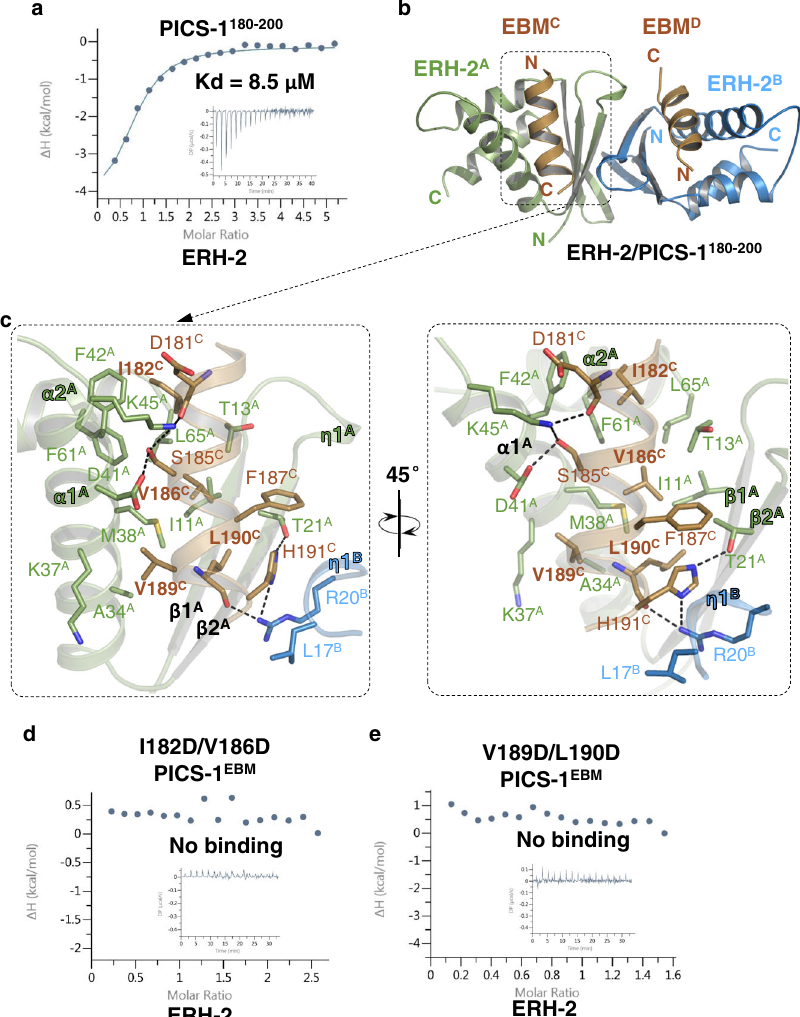
Fig. 3 The structure of ERH-2 dimer bound with EBM. a ITC binding curves for EBM with ERH-2. b Overall structure of the ERH-2 dimer with two EBM molecules. The two protomers in ERH-2 dimer, ERH-2 A and ERH-2 B , are shown in green and blue cartoon, respectively. Two EBM molecules, EBM C and EBM D , that bind to the ERH-2 dimer symmetrically, are shown in brown cartoon. c Detailed interactions between EBM C and ERH-2 dimer. Residues involved in ERH-2/EBM interaction are shown in sticks. Hydrogen bonds are shown in black dashes. d , e ITC curves for EBM mutants with